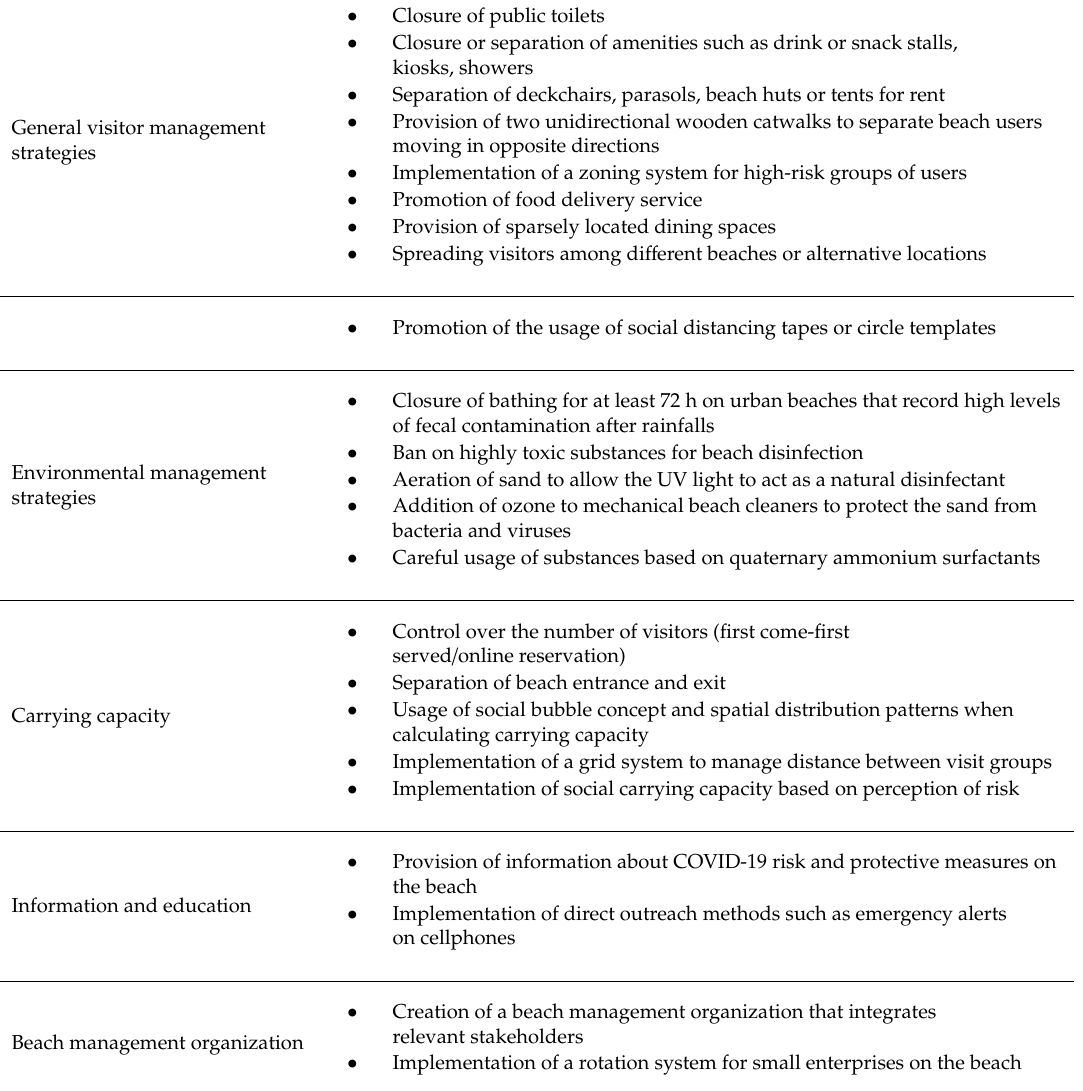
Table 1. Management strategies to deal with COVID-19 on